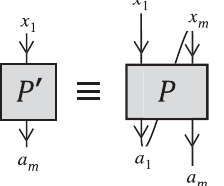
FIG. 6. Example of a wiring. A two-party box P is mapped into a single-party box P 0 by using as input for the second system the output generated by the